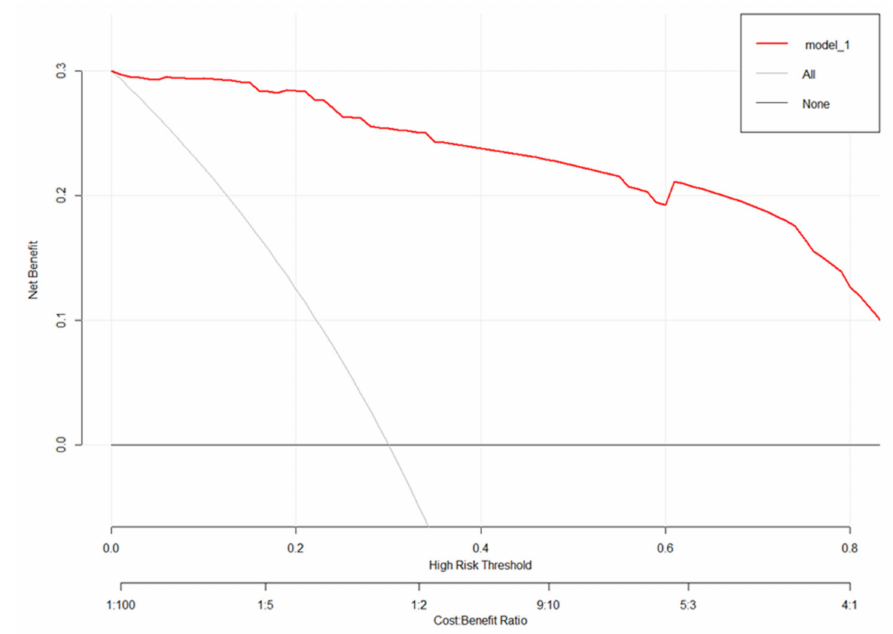
Figure 7. The decision curve analysis diagram of the